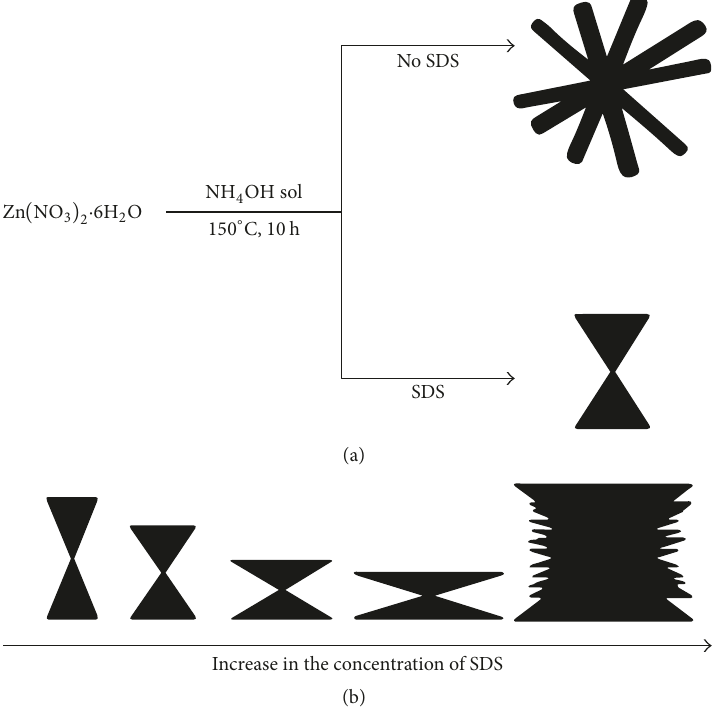
Figure 7: (a) Schematic presentation of formation of ZnO nanodumbbells and (b) changes of nanodumbbells size as function of amount of SDS